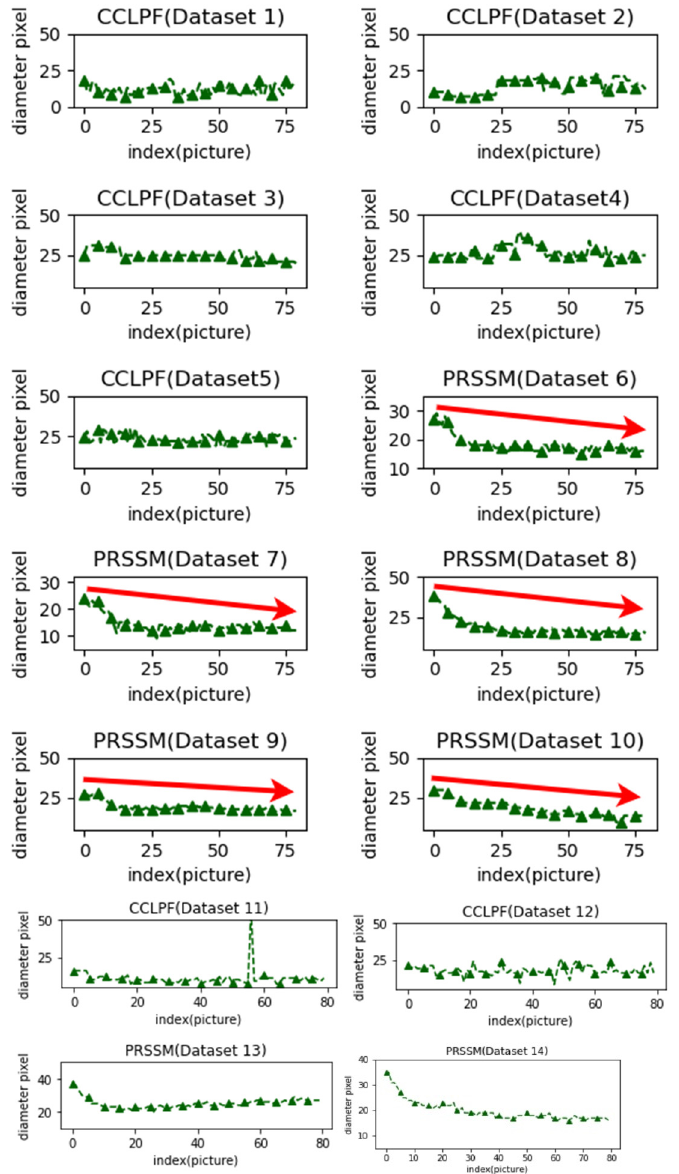
Figure 57. Measured pupil diameter data.